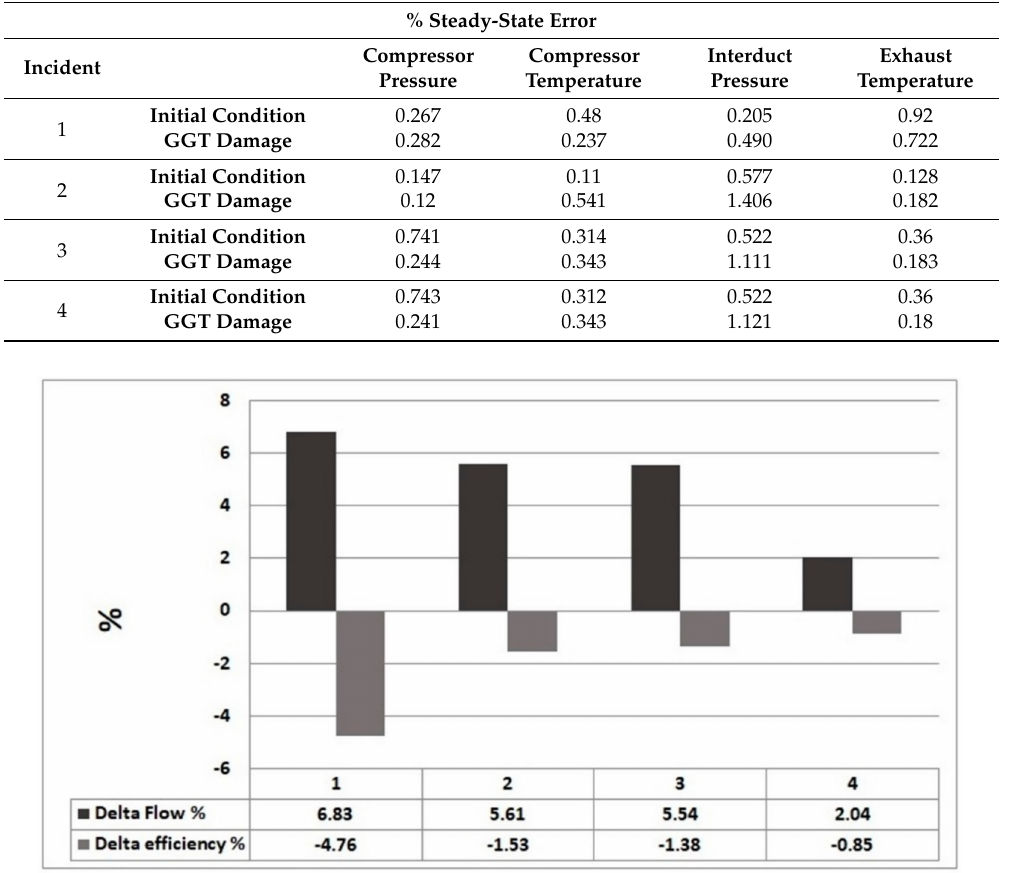
Table 6. Error between measured and simulated data for compressor discharge temperature, compressor discharge pressure, interduct pressure, and exhaust temperature for the four GGT damage incidents at steady-state.